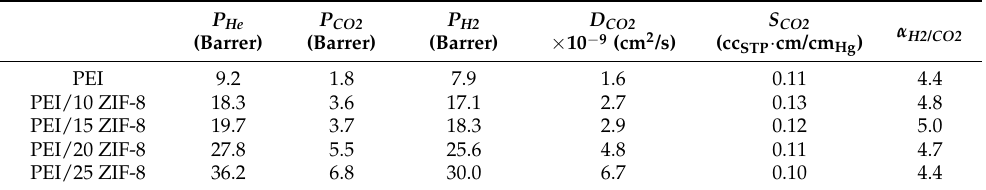
Table 3. Gas transport properties of the PEI/ZIF-8 membranes (the uncertainty was better than 5% for P and D and better than 10% for S and α